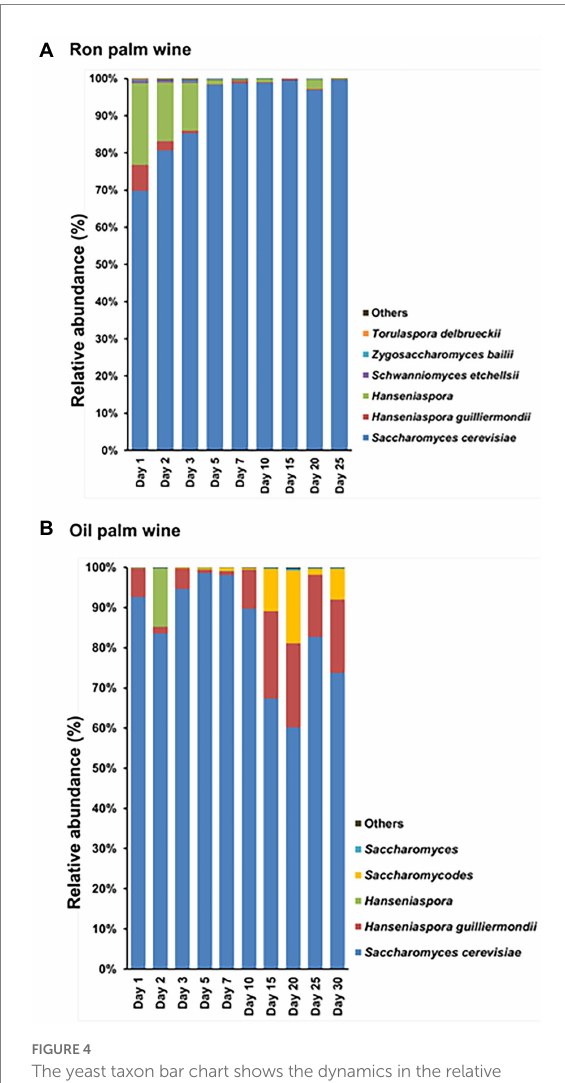
FIGURE 4 The yeast taxon bar chart shows the dynamics in the relative abundance (%) of predominant yeast species during ron palm wine (A) and oil palm wine (B) tapping days. The taxa with a mean relative abundance of <1% across the samples are combined and shown as others.